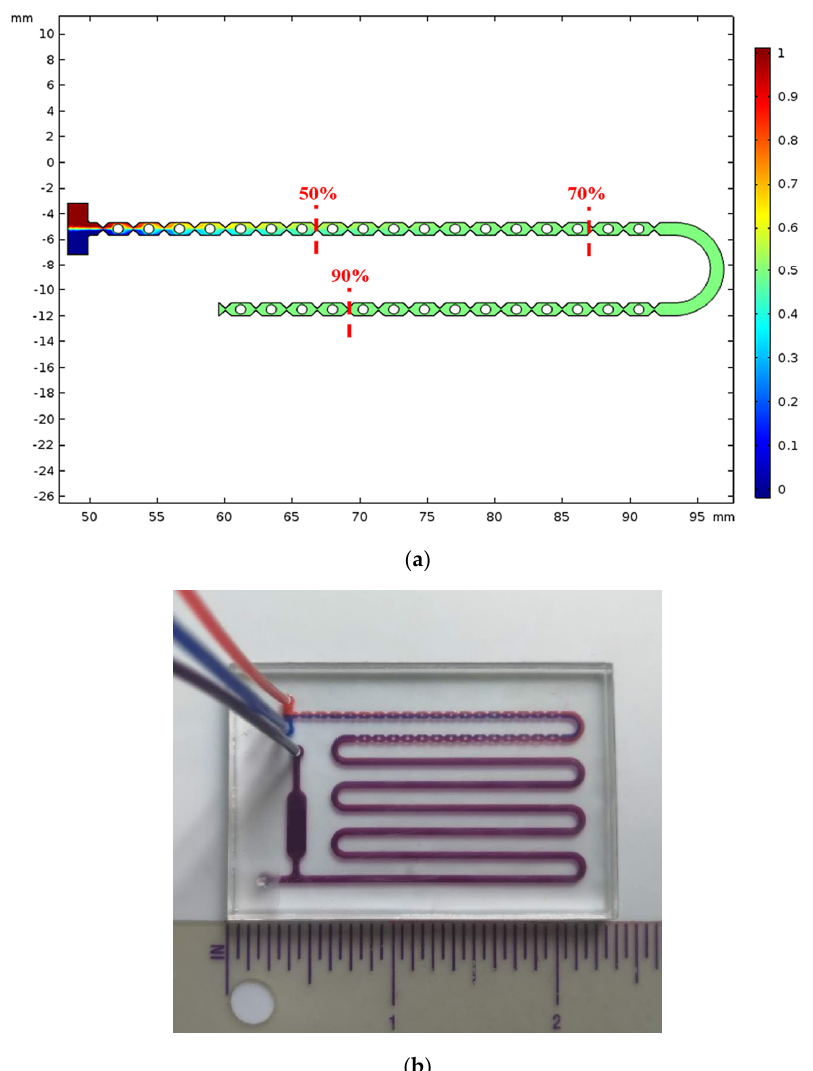
Figure 1. ( a ) The simulation on mixing efficiency of the mixing channel; ( b ) The mixing of two inks in the microfluidic chip.